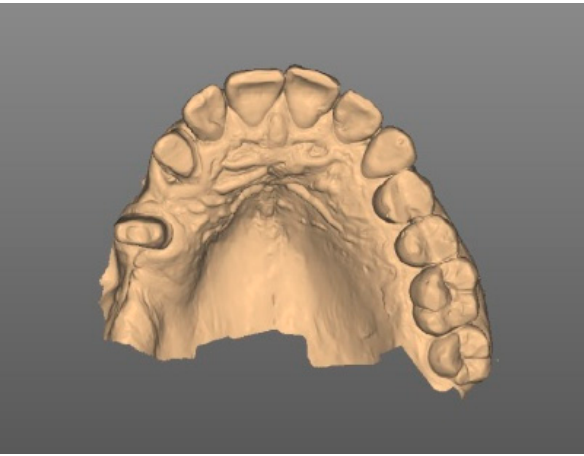
Figure 2. Digital impression of the upper jaw.